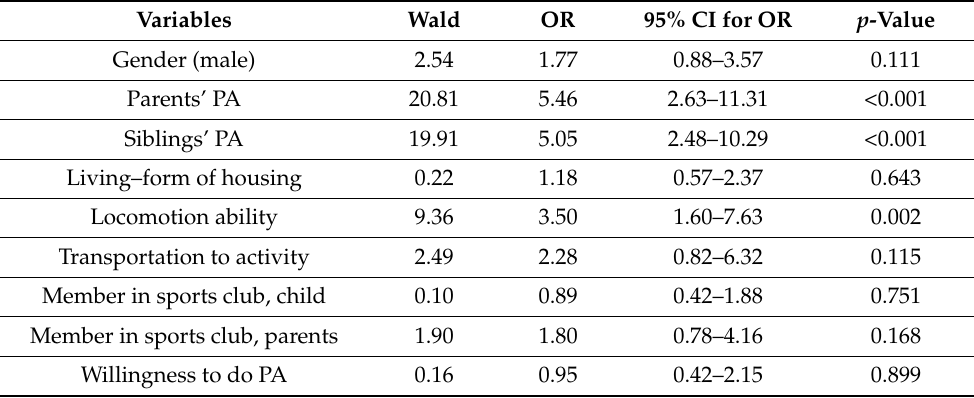
Table 5. Variables associated with physical activity (PA) among children/adolescents with DS. Results from a logistic regression model. Odds ratios (OR) and 95% confidence intervals (CI) and p -Value ( n =